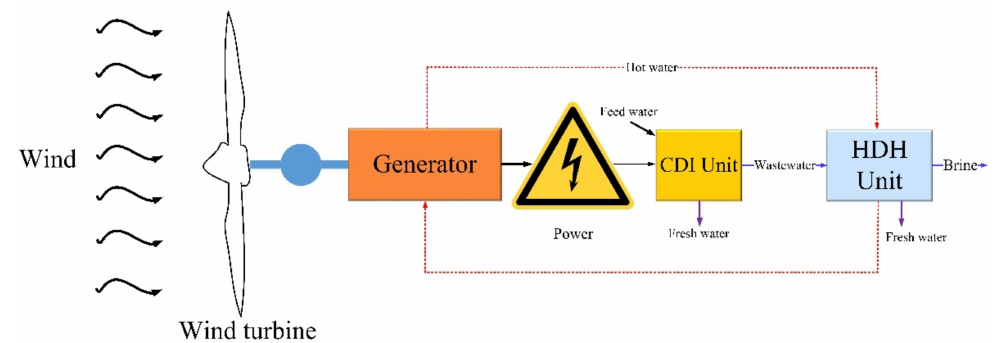
Figure 15. Schematic of wind energy-driven CDI–HDH desalination